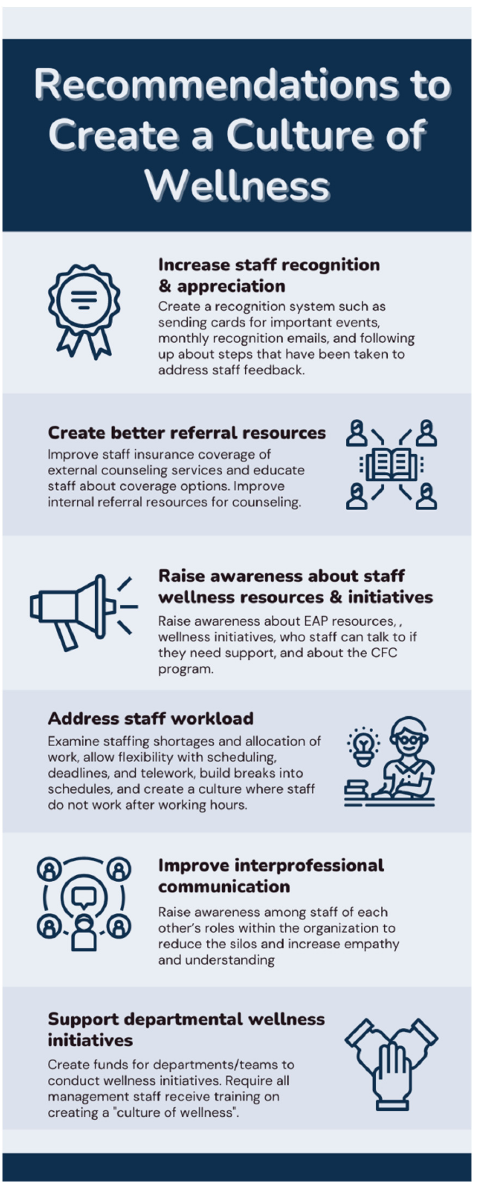
Figure 4. Recommendations to create an institutional culture of wellness